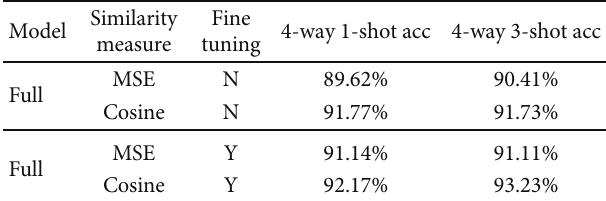
Table 3: Model performance on Sebastien Marcel dynamic